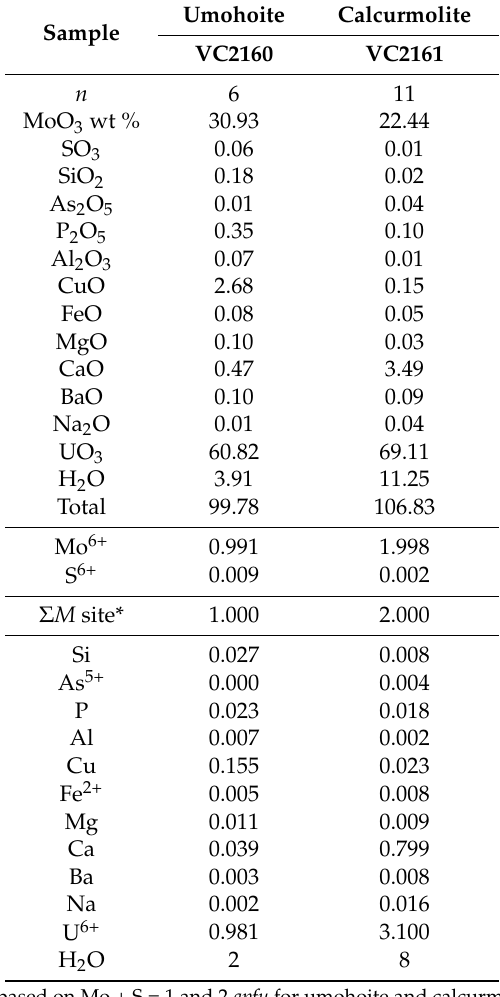
Table 11. Chemical composition of umohoite and calcurmolite.